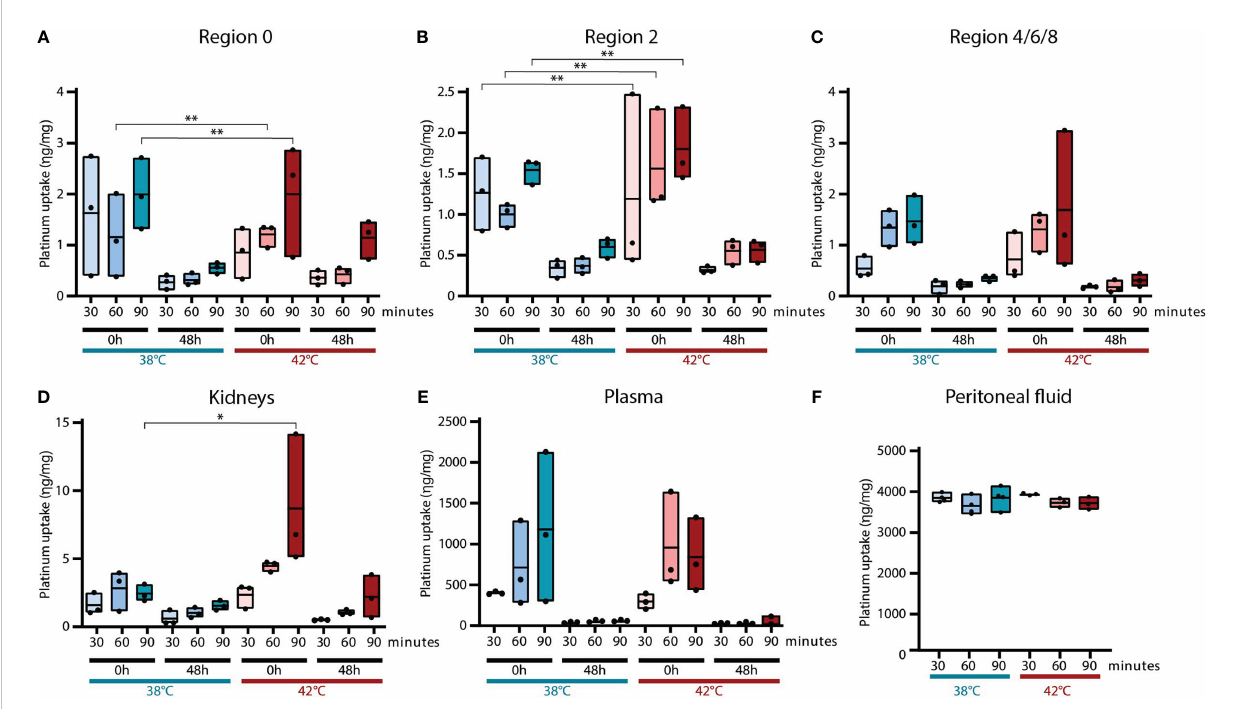
FIGURE 5 Platinum uptake in tumors and normal tissue. The platinum uptake was measured using ICP-MS in tumor lesions, kidneys and plasma collected 0 hours and 48 hours after HIPEC treatment. Tumor samples were collected from three different regions: 0 (A) , 2 (B) and 4/6/8 (C) . To de fi ne the normal tissue toxicity, platinum levels were also measured in the kidneys (D) and plasma (E) . Platinum levels in peritoneal fl uid collected at the end of each HIPEC procedure was also analyzed (F) . Values of 3 samples are presented with the min/max ± mean. Signi fi cant p-values are reported as * <0.05 and